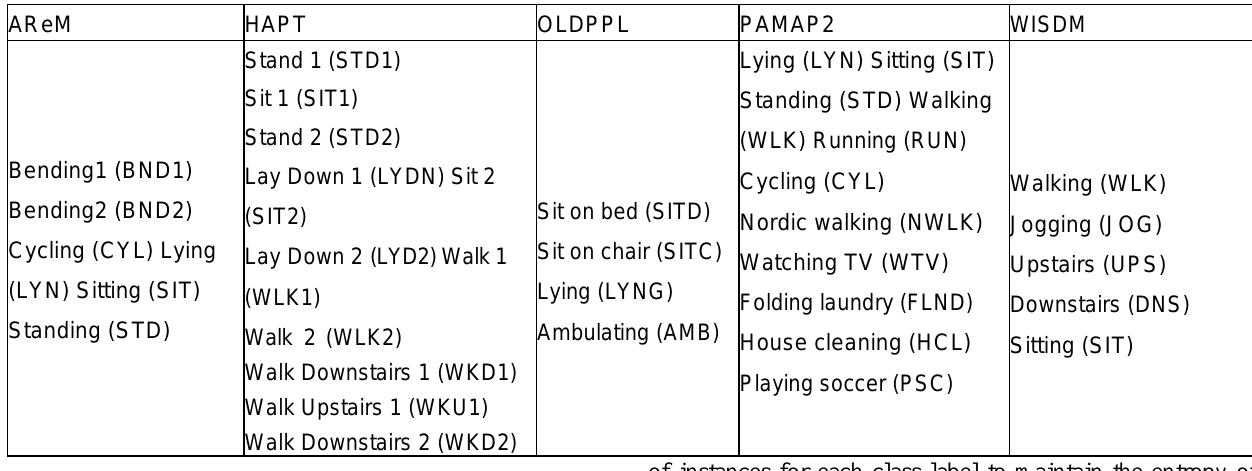
Table 2. Dataset features set with abbreviations (walk and stand for specific duration of time. Table 2